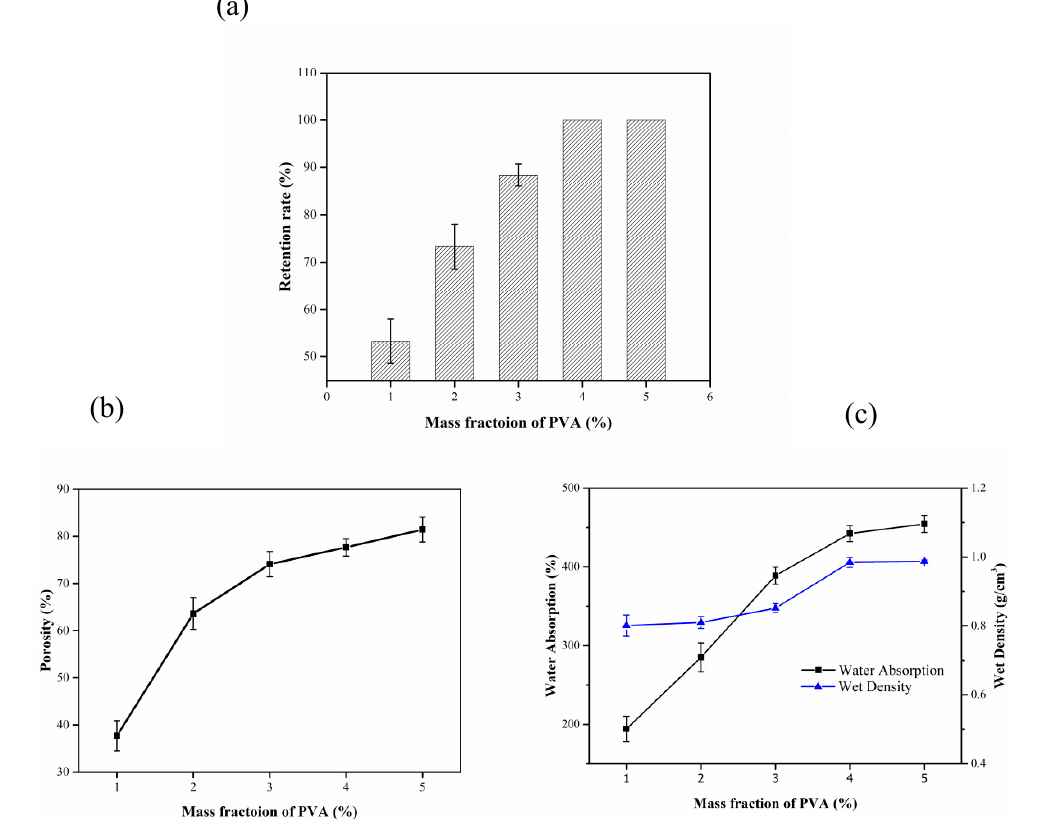
Figure 3. Influence of PVA mass fraction on the performance of composite carrier. ( a ) Effect of the mass fraction of PVA on retention rate; ( b ) Effect of the mass fraction of PVA on porosity; ( c ) Effect of the mass fraction of PVA on water absorption and wet density.